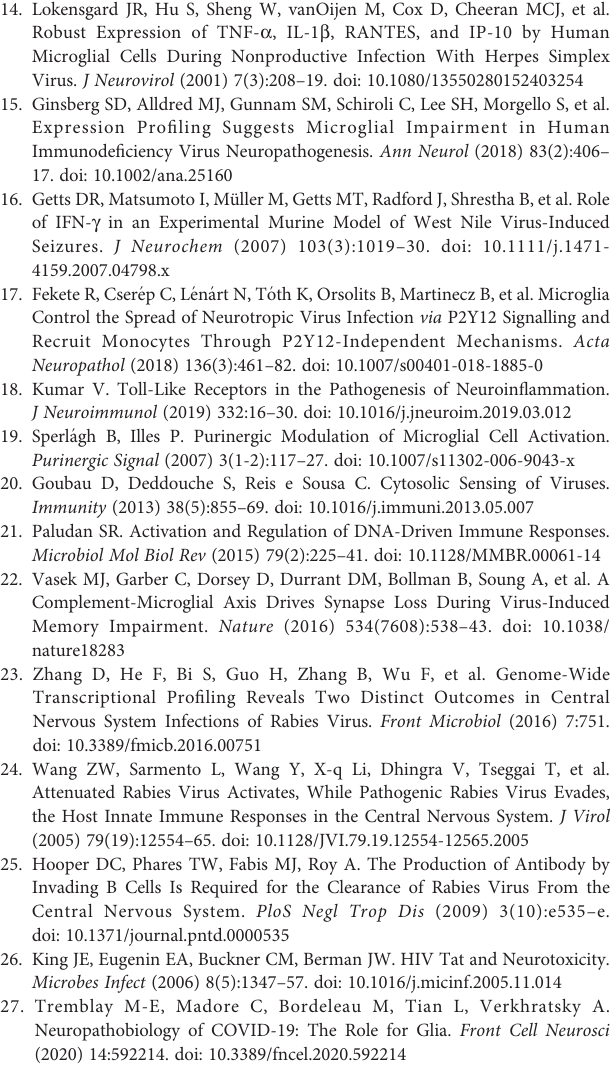
Supplementary Figure 1 | Detection of PHEV and Iba 1 in vary brain regions. Brain samples were harvested at 3-7 dpi and anatomically separated into 6 parts including olfactory bulb, cortex, hippocampus, thalamus, brainstem, and cerebellum.TotalRNAwasextractedtoevaluatetheviralloadandIba1expression. Supplementary Figure 2 | Optimization of PLX3397 treatment in mice. (A) Mice orally administrated with 200mg/kg or 290mg/kg as shown in . Morphological changes and counts of microglia were analyzed at -17 d, 7 d, and 0 d. Bars, 50 m m. (B) Body weight change. (C) Survival curves. Supplementary Figure 3 | Effection of Cd lipos i.v. injection on CNS microglial activation. Mice i.v. injected with Cd lipos as shown in . Morphological changes (A) and counts number (B) of microglia were detected at -2 d, 2 d, and 4 d. Bars, 50 m m. (C) Iba 1 mRNA expression was tested using